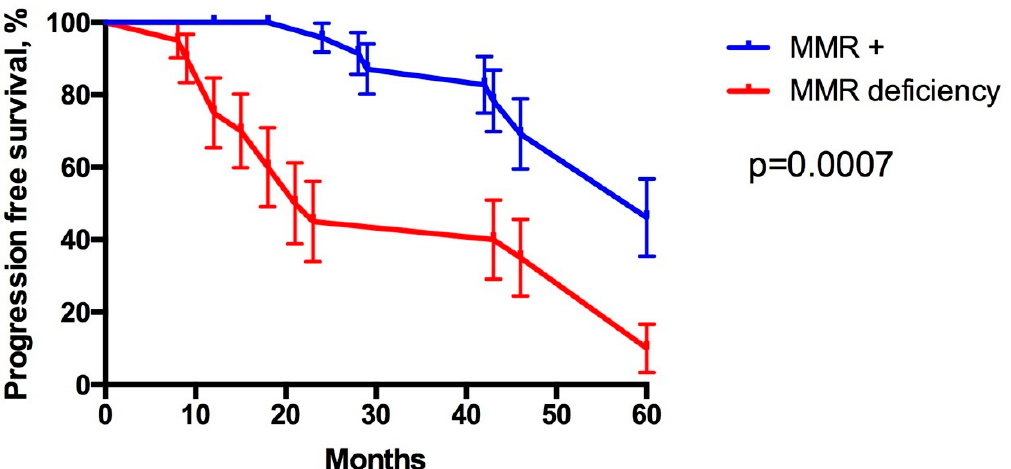
Figure 8. Progression-free survival of prostate cancer patients with MMR deficiency (red line) and maintained MMR expression (blue line). Kaplan–Meier method using the log-rank (Mantel–Cox) test; p = 0.0007.